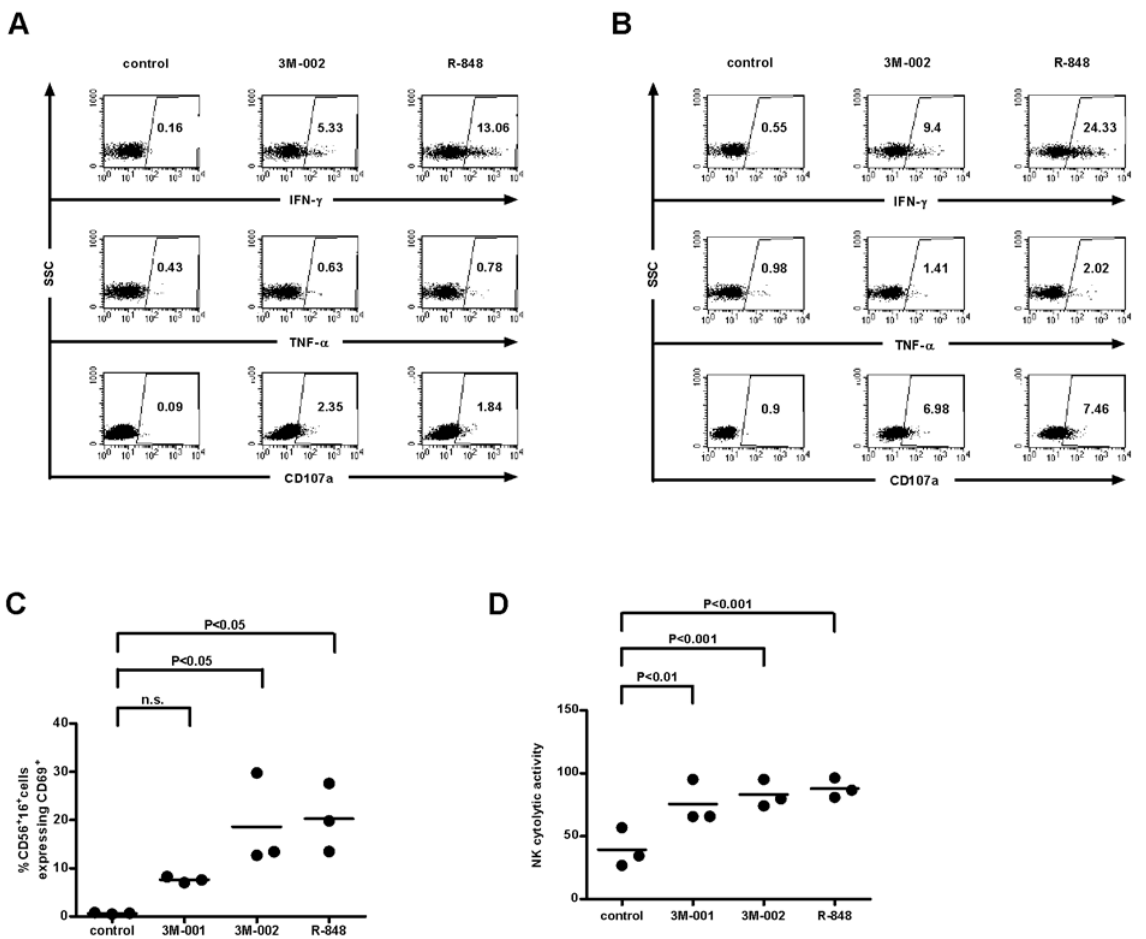
Figure 4. Triggering TLR8 or 7/8 results in strong activation of NK and CD8 + T-cells. PBMC were treated with the TLR agonists and 24 h later analyzed for intracellular IFN- c , TNF- a and CD107a expression for CD8 + T-cells (A) and NK (B), for the expression of CD69 on NK cells (n=3) (C) and for the NKs’ cytolytic activity against K562 cells (n=3) (D). Data were first analyzed by one-way analysis of variance and if tested significantly different, by Bonferroni’s multiple comparison